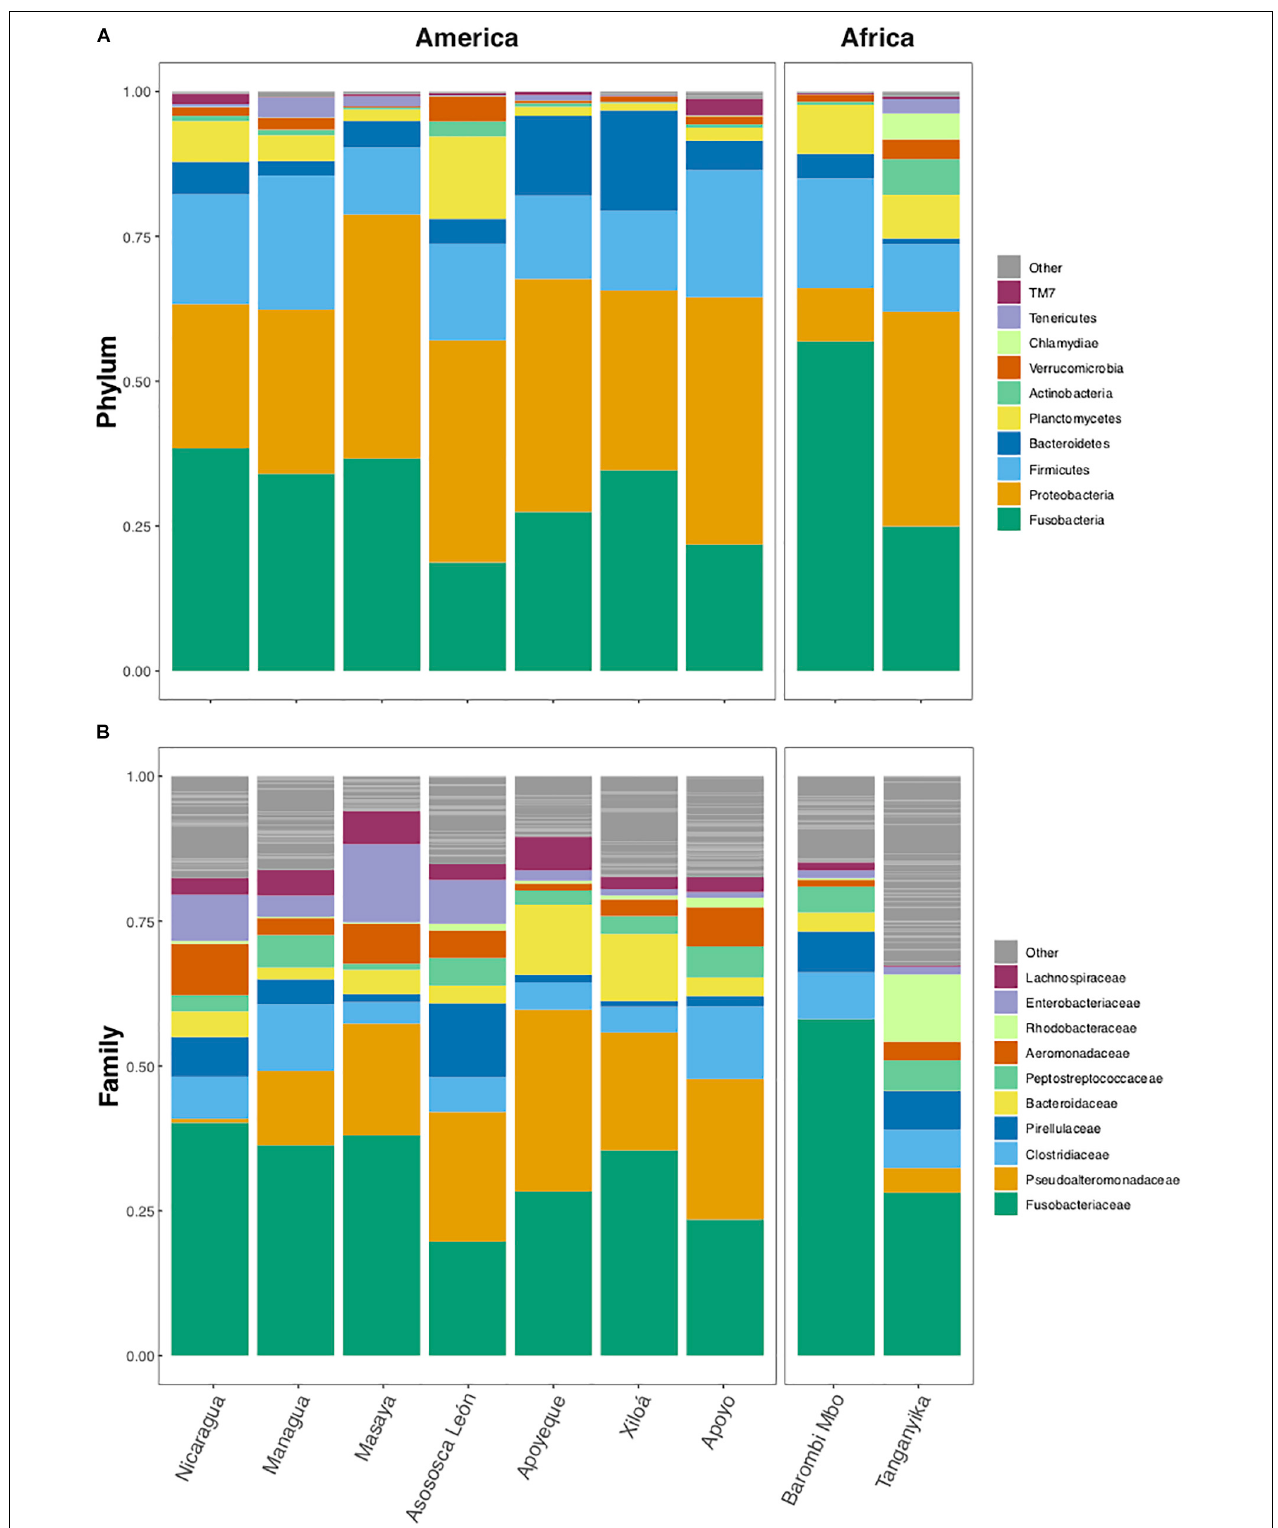
FIGURE 3 | Average relative abundance by lake of bacterial taxa at phylum (A) and family (B) levels. Dominant taxa are comparable across lakes and continents. Only the 10 most abundant phyla and families are color-coded, while “Others” (gray) include all remaining taxa. The analyses are based on the rarefied dataset